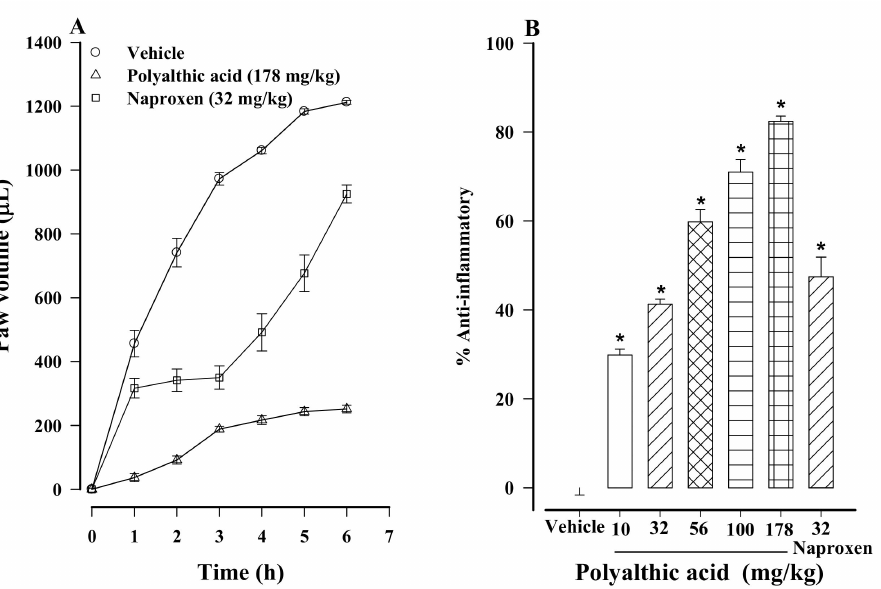
Figure 7. ( A ) Temporal course of the anti-inflammatory activity generated by the oral administration of polyalthic acid (178 mg/kg) to rats with 1% carrageenan-induced inflammation. Data are expressed as the volume of the edema on the left hind paw. ( B ) Dose-dependent anti-inflammatory effect elicited by polyalthic acid (10–178 mg/kg). Data are expressed as a percentage of activity against inflammation. Bars represent the mean ± SEM ( n = 6). * p < 0.0001 vs. the vehicle-treated rats injected with carrageenan (1%), as determined by one-way ANOVA and the Student–Newman–Keuls